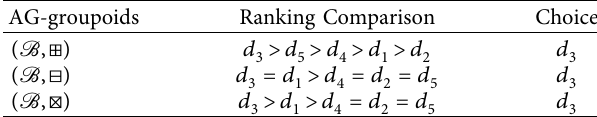
Figure 5: Score, accuracy, and ranking comparison for F . 3 Table 19: Ranking comparison with the optimal choice of Table 17: Rankings of chatbots under ( B , ⊠ ) .